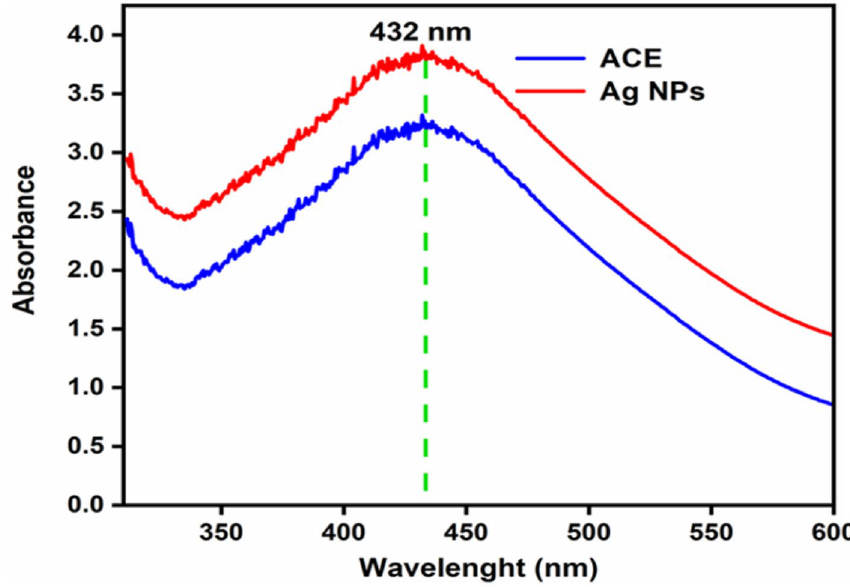
Figure 2. UV–visible absorption spectra of ACE and Ag. NPs of Plantago lanceolata